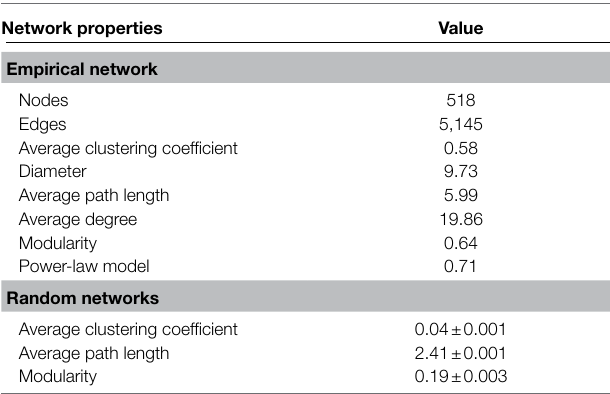
TABLE 2 | Topological properties of co-occurrence networks of the Tibetan lake bacterial communities and their corresponding random networks. Network